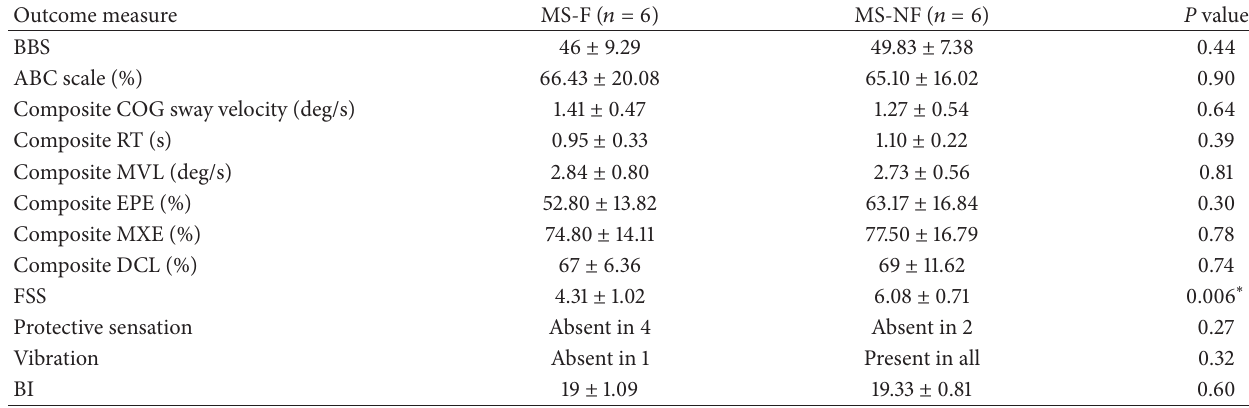
Table 2: Test scores for the MS-F and MS-NF